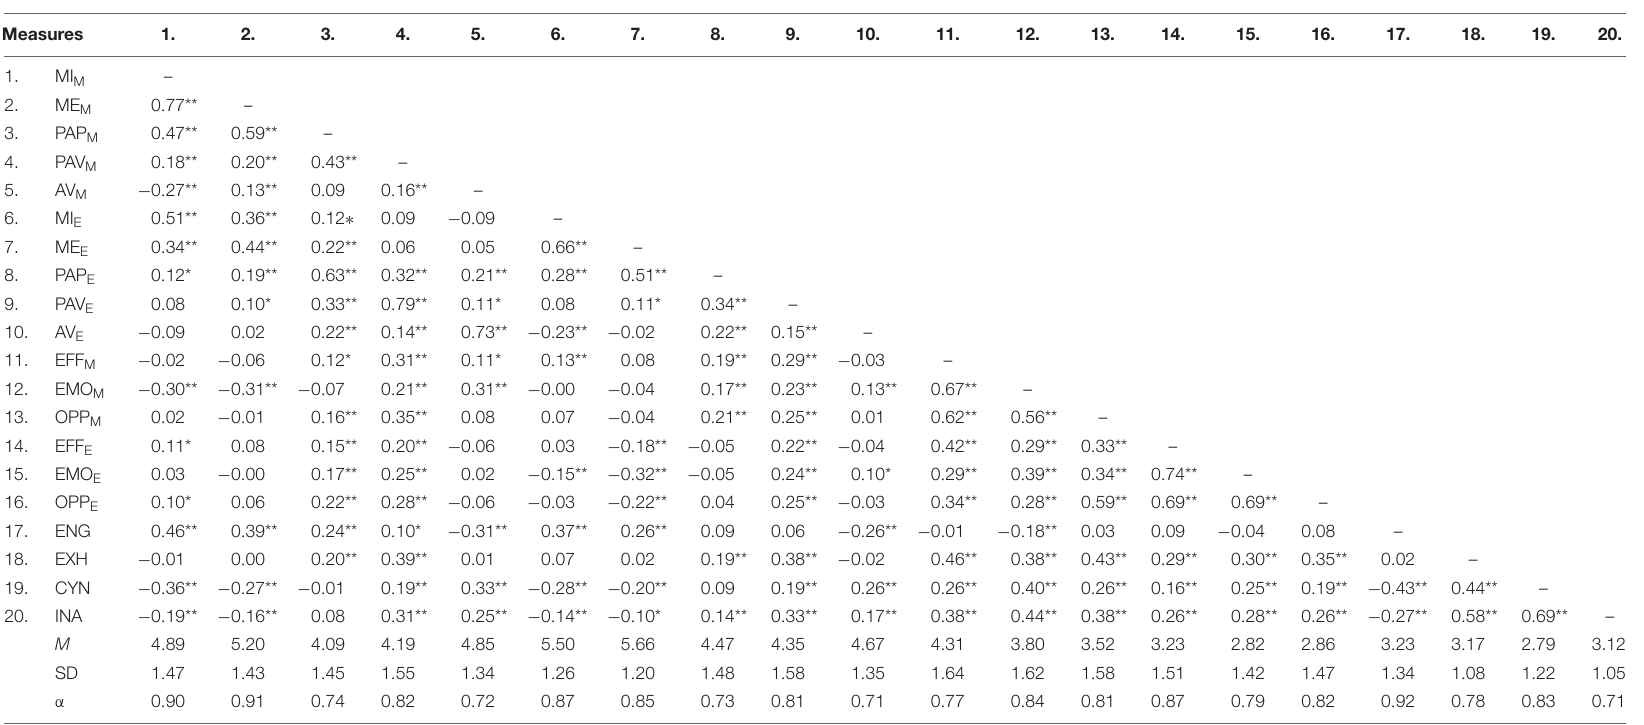
TABLE 1 | Bivariate correlations, descriptive statistics, and internal consistencies for all variables.